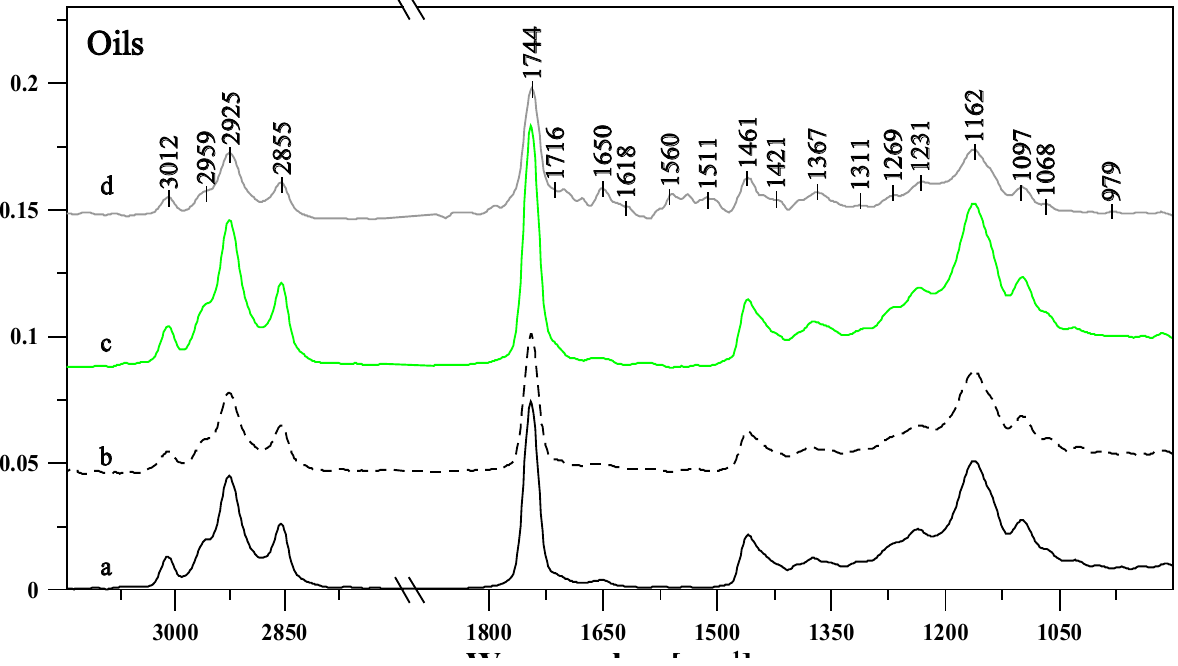
Figure 2 : ATR-FTIR spectra for selected Moldavian dragonhead oil samples stored at room temperature (20-22 o C): a – immediately after pressing, b – two weeks after pressing, c – four weeks after pressing, d – 8 weeks after pressing. The spectra are presented within the spectral range from 900 to 3150 cm -1